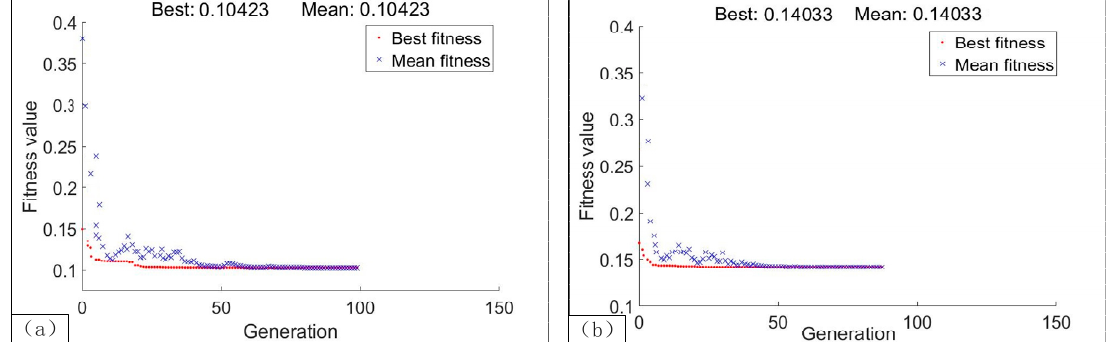
Figure 21. Fitness function values by genetic algorithm (GA): ( a ) LEC mode; ( b ) LSR mode.